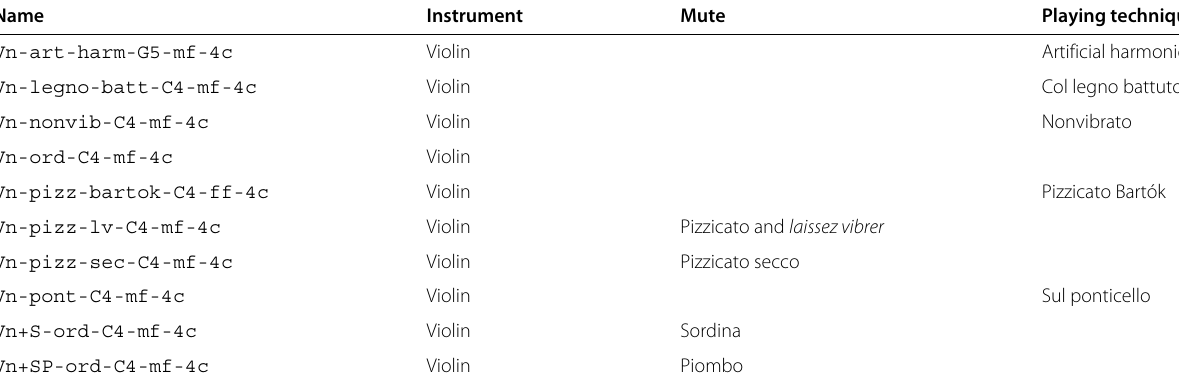
Table 2 Full list of audio stimuli (2/2). In each instrument, a blank space in the rightmost column denotes the ordinary playing technique ( ordinario